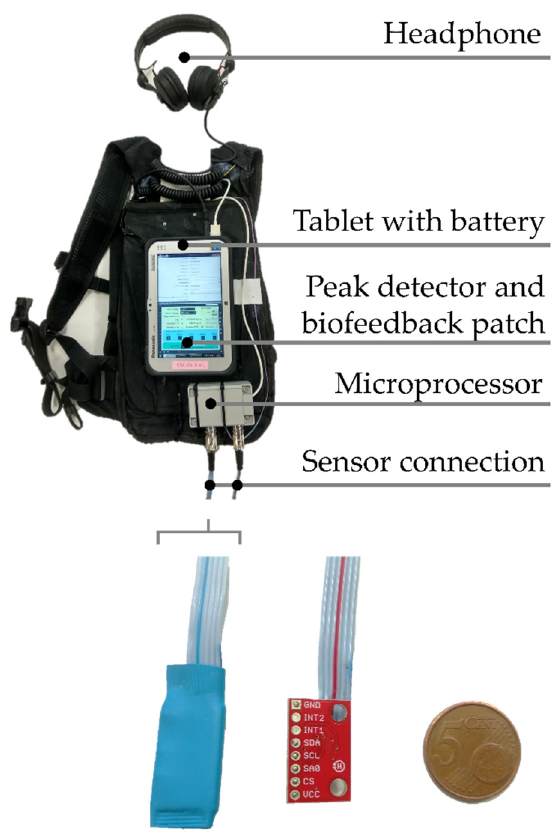
Figure 1. (upper panel) Picture from the instrumented backpack. (lower panel) The accelerometer (left) with and (middle) without the shrink sleeve and (right) a 5-cent piece.